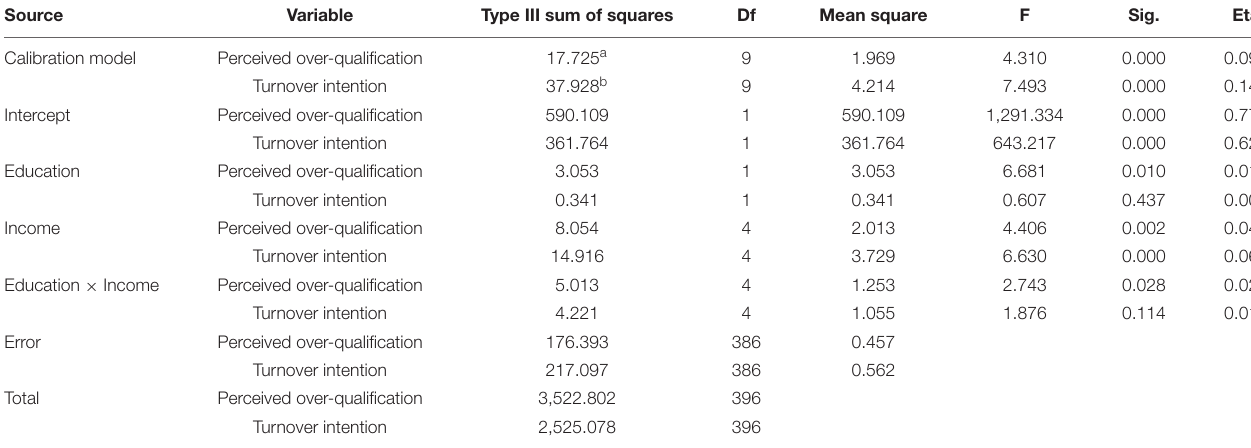
TABLE 4 | Results of two-way ANOVA analysis. Source Variable Type III sum of squares Df Mean square F Sig.